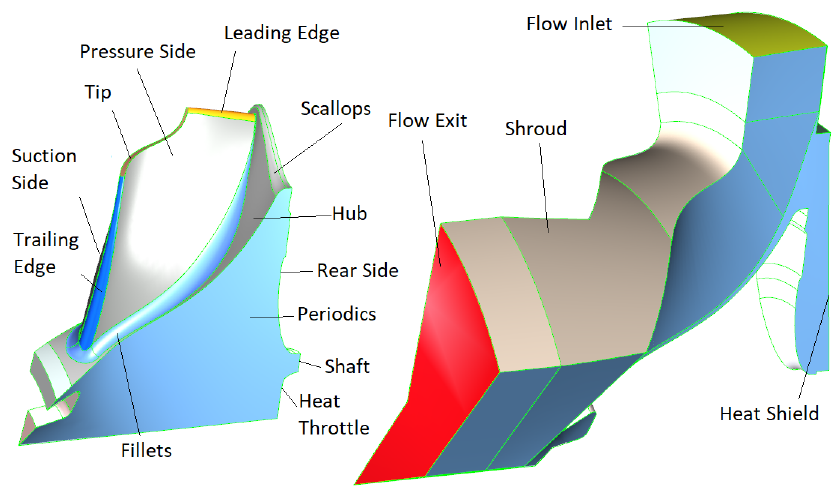
Figure 5. Solid (l.) and fluid (r.)